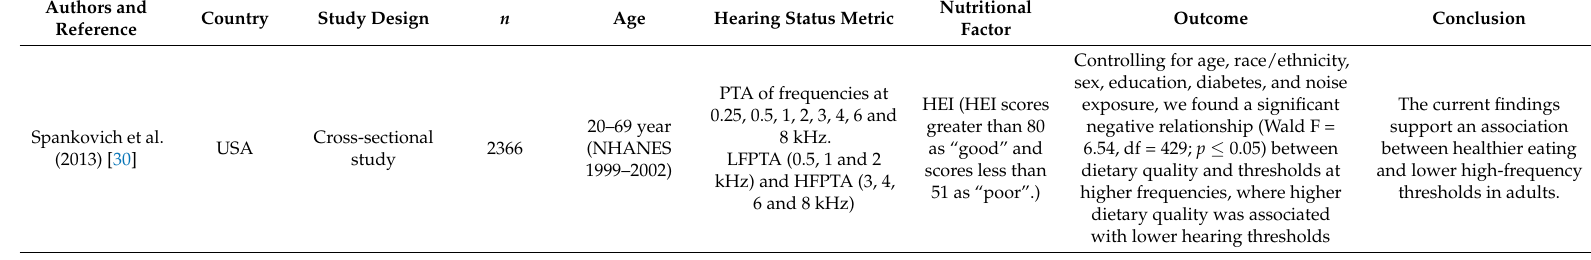
Table 2. Studies assessing the association between hearing status and general nutritional status or dietary